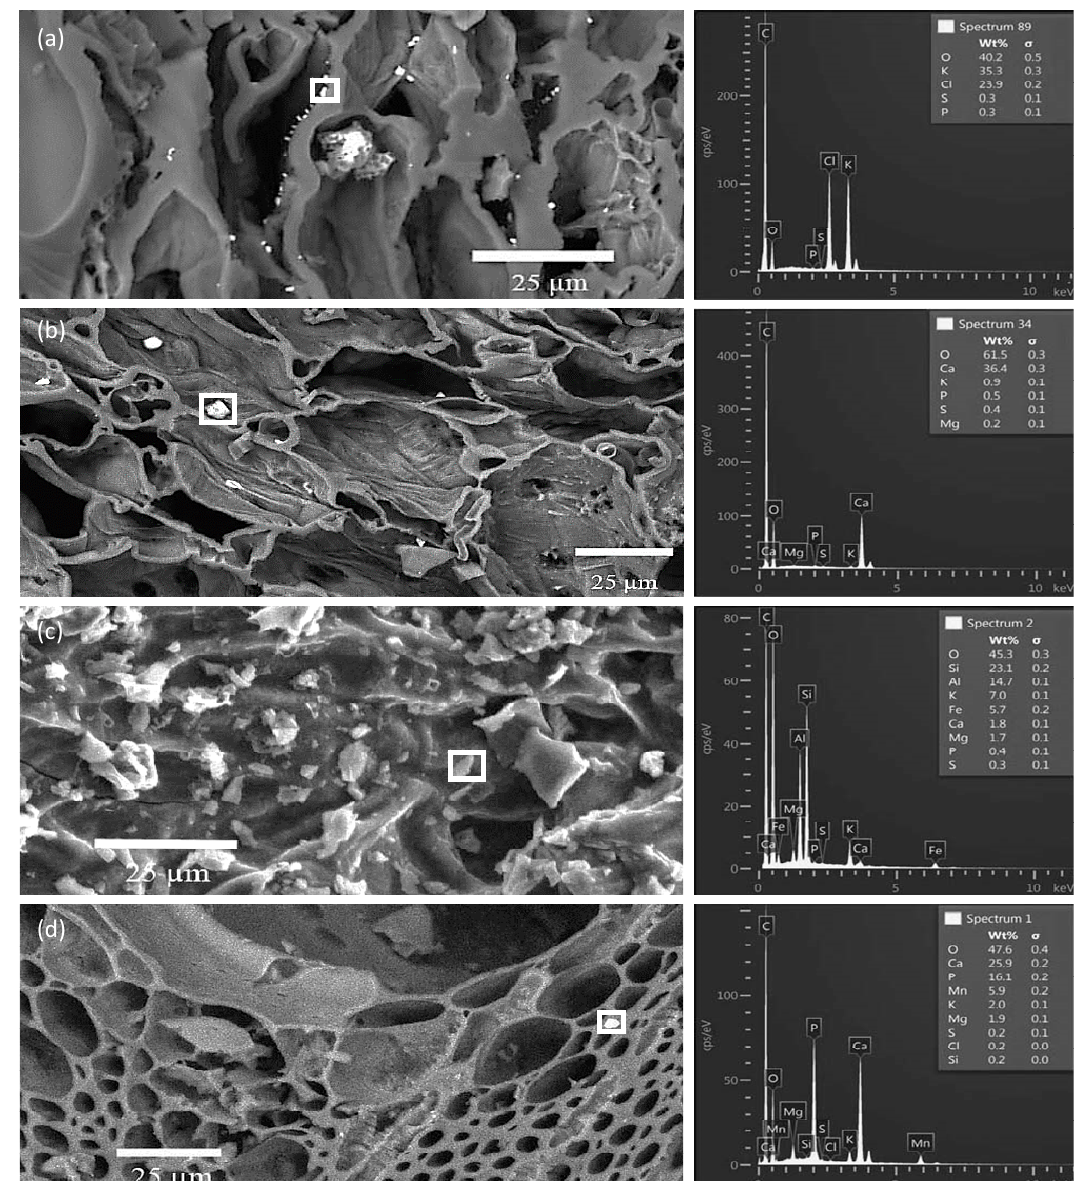
Figure 6. SEM images and spectra of particles on fracture surfaces of original mangosteen biochar ( a ), mangosteen biochar recovered from soil after 8 ( b ) and 1 ( c ) months. Eucalyptus biochar recovered from soil after 8 months ( d ). Energy dispersive X-ray spectrometry (EDS) spectra and analyses of the indicated mineral particles are shown.